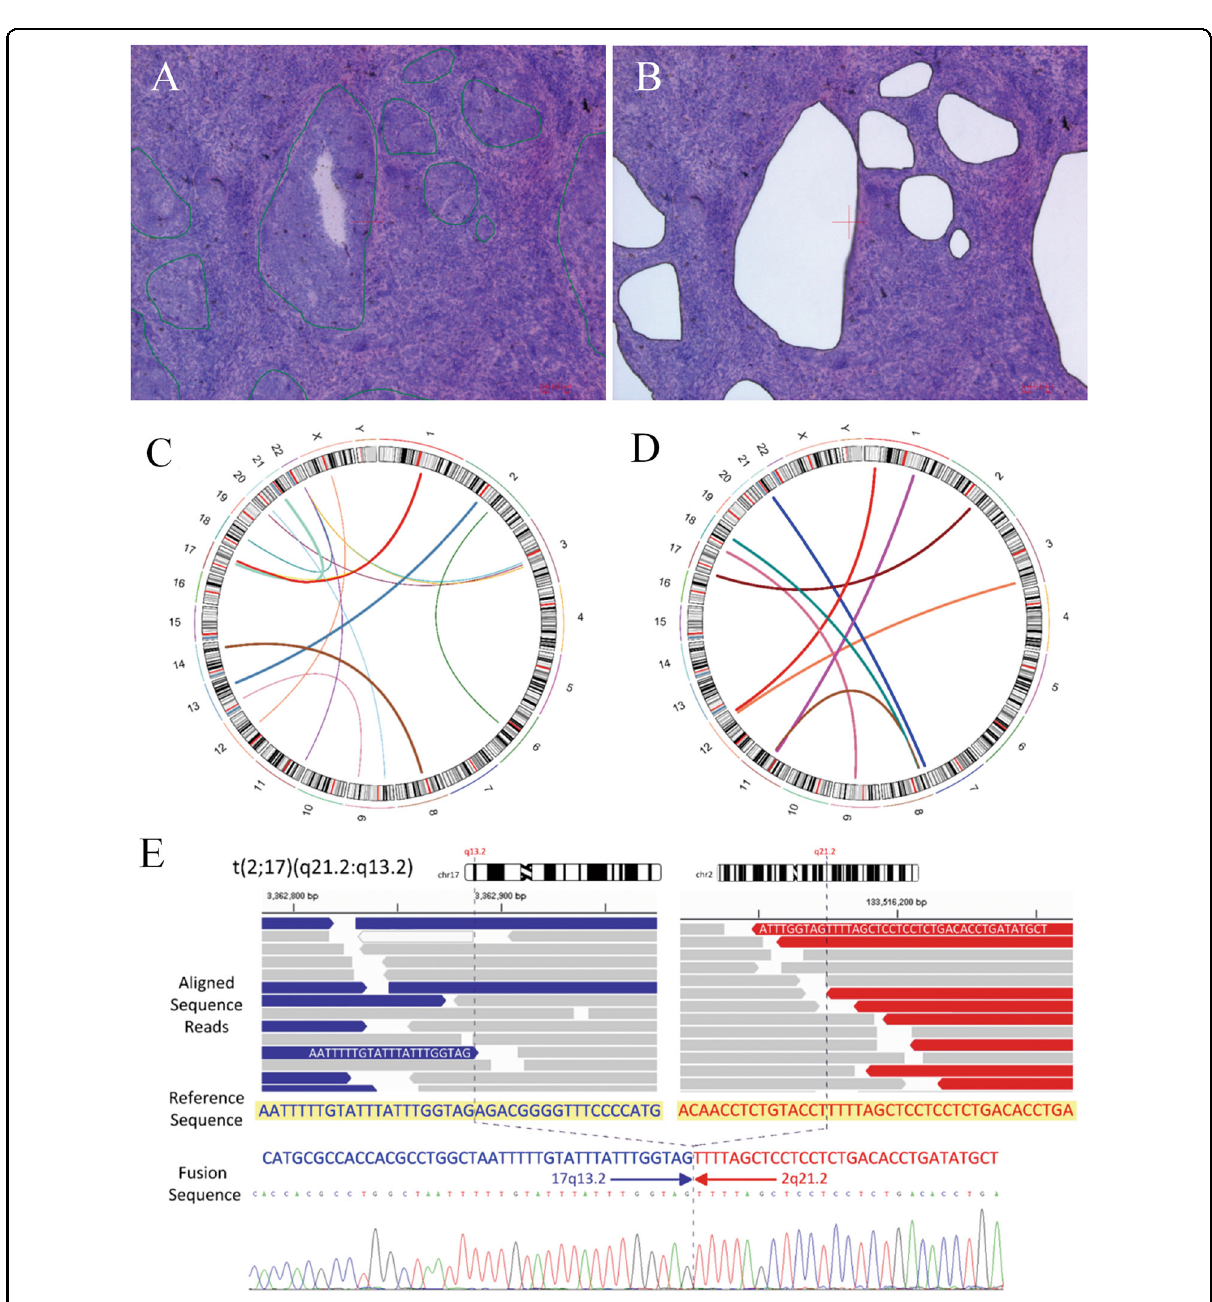
Fig. 2 Identi fi cation of personalized cancer-speci fi c rearrangements. a Cancer cells in primary tumor tissues before LCM. Cancer cell nests are marked with green lines. b Remnant normal cells and in fl ammatory cells after LCM. c Circos diagram of the rearrangements in GC17. The inter- and intrachromosomal arcs in the center indicate chromosomal rearrangements. d Circos diagram for GC32. e Analysis of the rearranged sequence marked in D for GC32 by Sanger